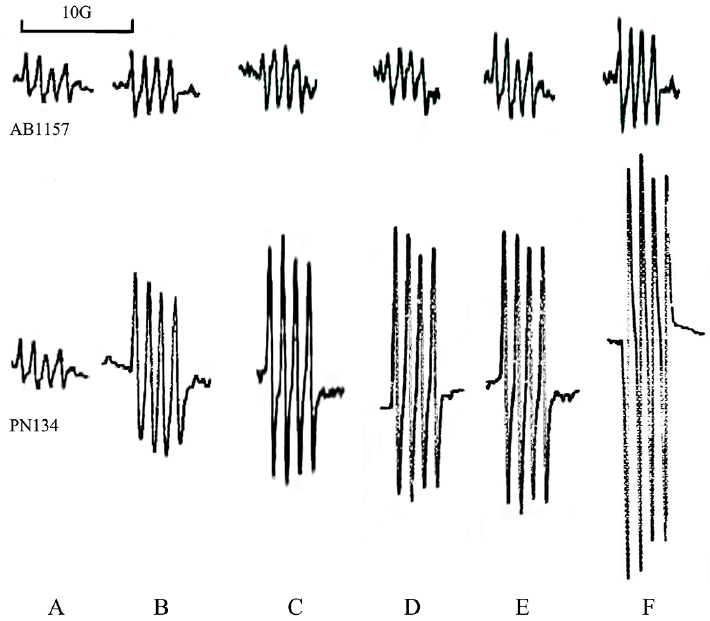
Figure 1. Effect of polychlorinated biphenyls (PCBs) on the electron spin resonance (ESR) spectrum of superoxide in the culture of Escherichia coli . AB1157 is a wild type strain; PN134 is a sod mutant. Bar, 10G. ( A ) Medium control; ( B ) Culture of strains; ( C ) Culture with PCB153; ( D ) Culture with PCB180; ( E ) Culture with PCB11; ( F ) Culture with 4-OH-PCB11.